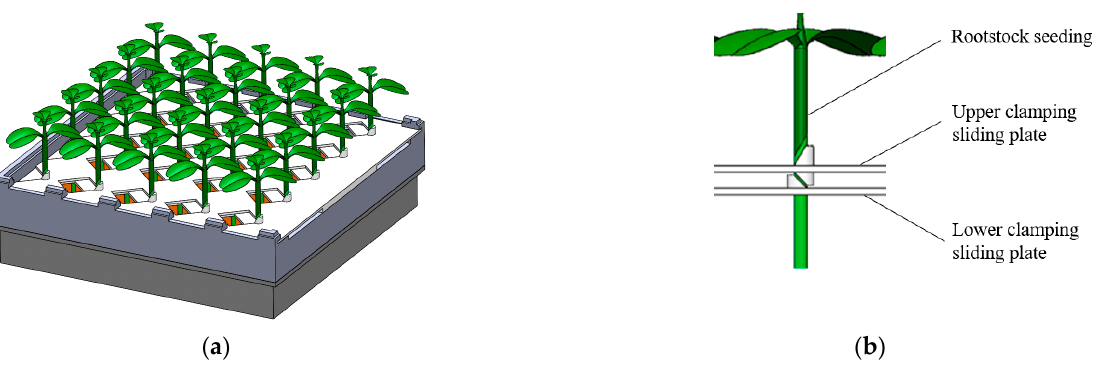
Figure 3. Rootstock seedlings with clamping and positioning device. ( a ) Clamping and positioning for full tray of rootstocks. ( b ) Details of rootstock seeding positioning.